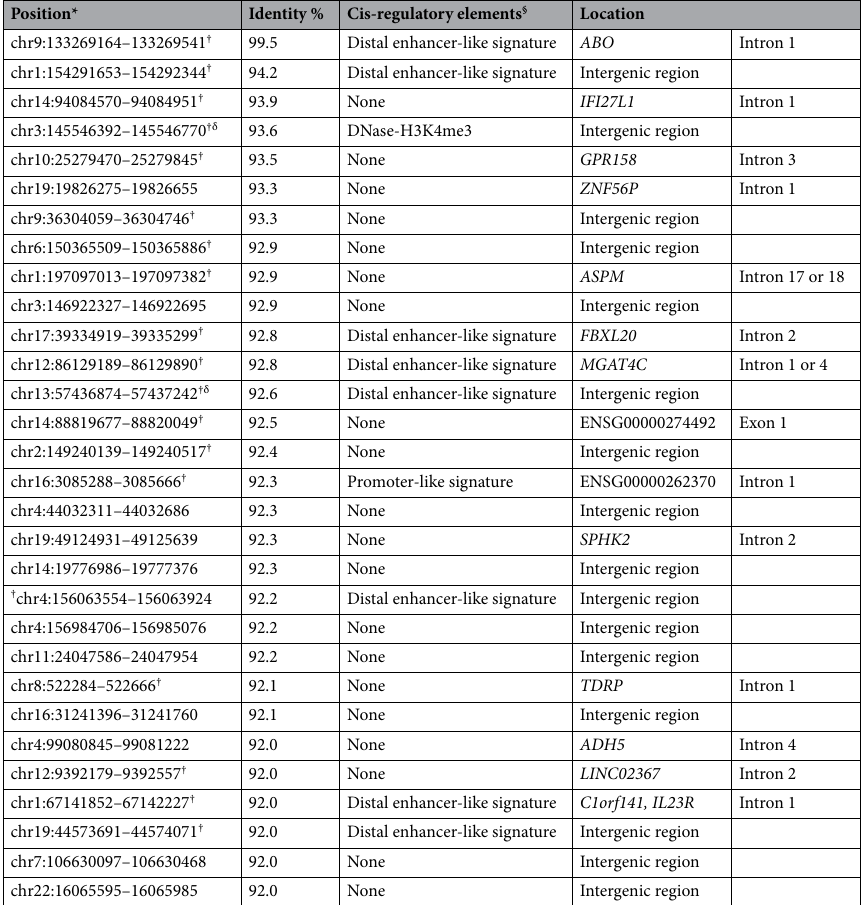
Table 2. Sequences homologous to the human + 5.8-kb site demonstrated by a BLAST search with candidates for estimated cis-regulatory elements. *Positions are described according to Human GRCh38/hg38. For the BLAST, a portion of the + 5.8-kb site of haplotype ABOInt1*01 belonging to LTR15 was used as the query sequence. Since the + 5.8-kb site in human GRCh38/hg38 belonged to haplotype ABOInt1*04 , there was a difference of two nucleotides between these + 5.8-kb sites. ‡ Descriptions are according to ENCODE Candidates Cis-regulatory Elements (cCREs). † Sequences indicated to belong to LTR15 by RepeatMasker. δ The